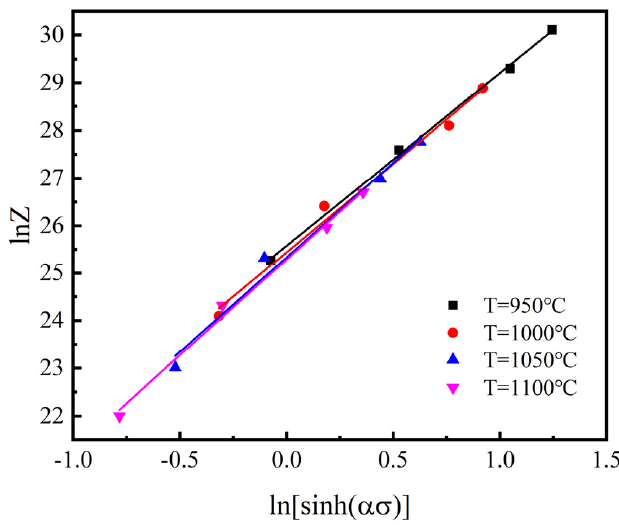
Figure 9. Fitting line, ln A by plotting lnZ vs. ln [ sinh ( ασ )] . According to the above method, the material constants are computed under different deformation strains within the range of 0.05–0.8 and the interval of 0.05. The relationships and the coefficients of the modified Arrhenius model are shown in Table 3. Table 3. The coefficients of the modified Arrhenius model for the 25CrMo4